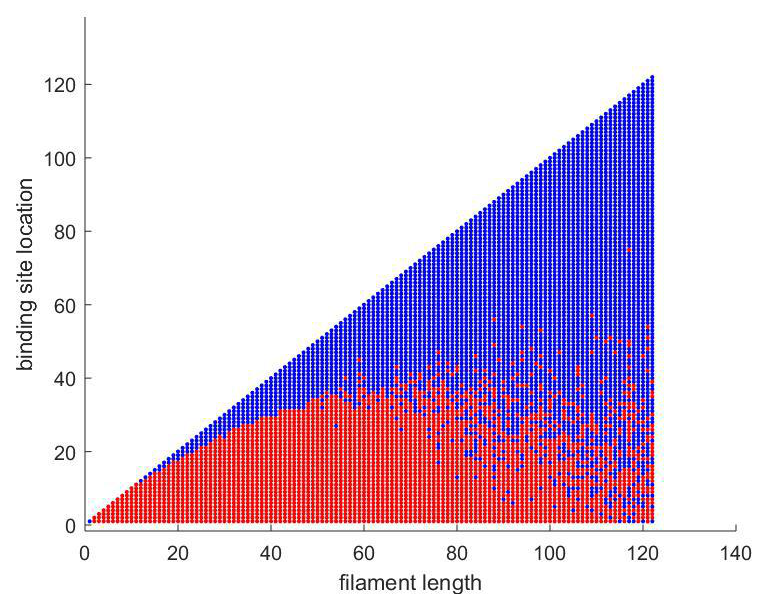
Figure 3. Variation in MFI of HDPE-HA composites with HA loading.